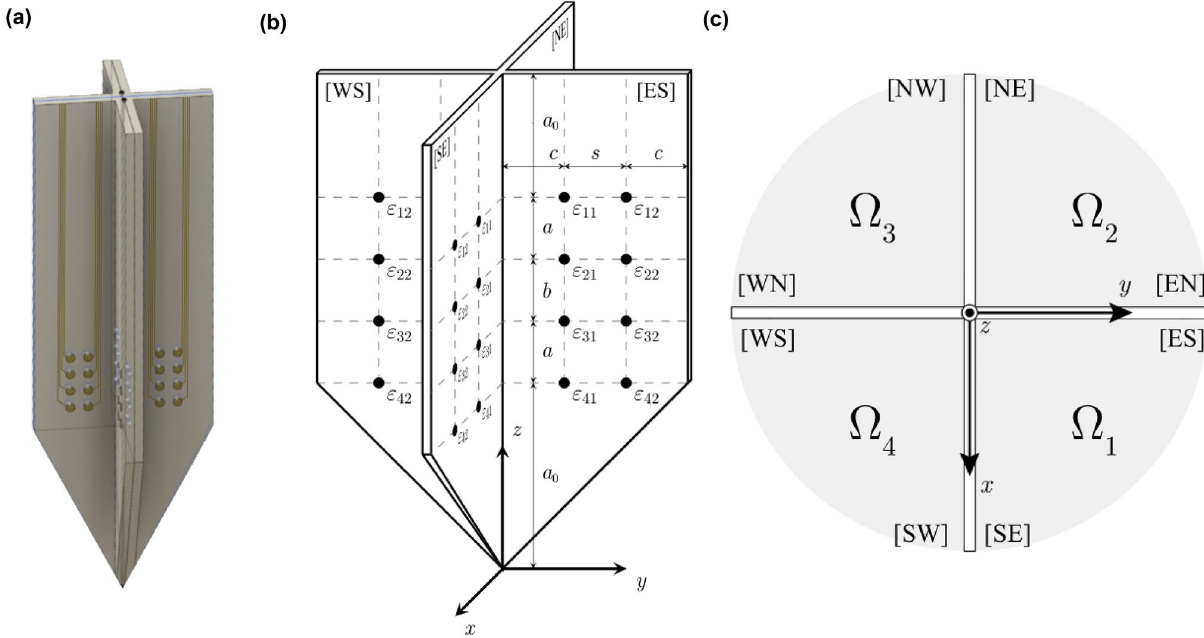
Figure 1. (a) Schematic representation of the needle. (b) Needle’s geometry (not to scale). (c) Needle’s top view.